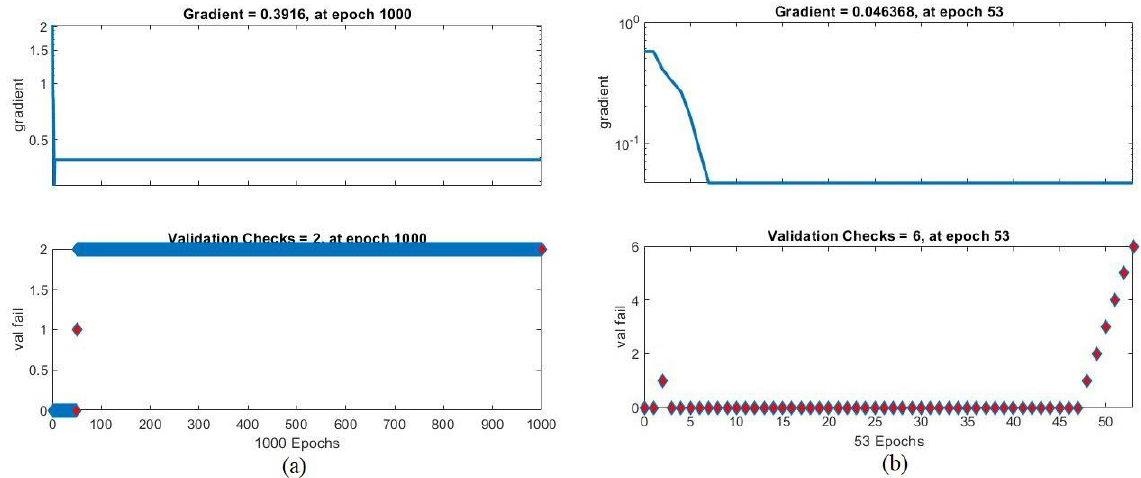
Figure 14. Gradient and validation check values of the ( a ) ALL_IDB1 and ( b ) ALL_IDB2 datasets.